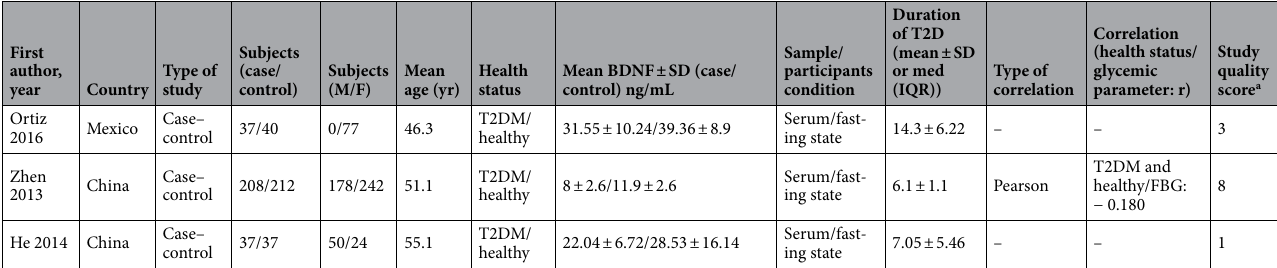
Table 1. Characteristics of the studies that were included in the present systematic review and meta-analysis. M male, F female, BDNF brain-derived neurotropic factor, ng/mL nano-gram/milli-liter, SD standard deviation, IQR inter-quartile range, T2DM type 2 diabetes mellitus, FBG fasting blood glucose, HOMA-IR homeostatic model assessment for insulin resistance, HbA1c glycosylated hemoglobin, IRI immunoreactive insulin, PDR proliferative diabetic retinopathy, NR not reported. a Based on Newcastle–Ottawa Scale (NOS).